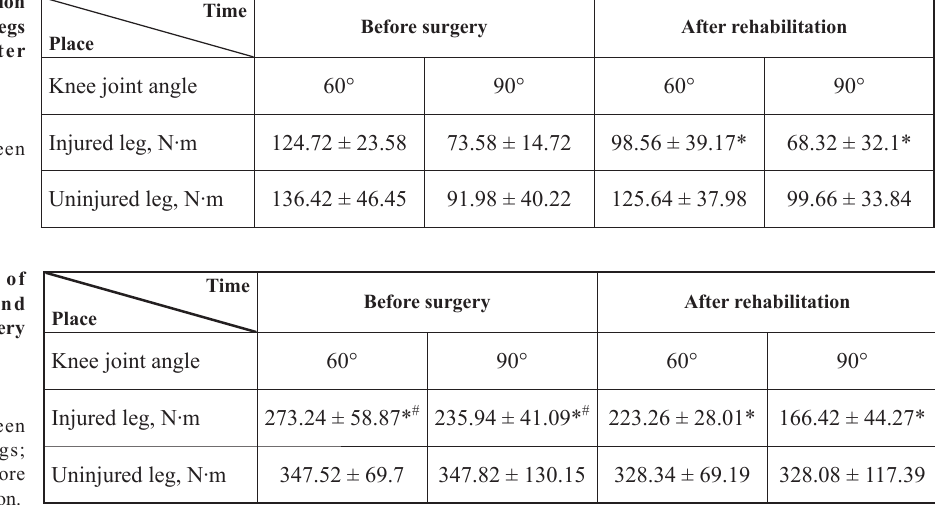
Table 1. MVC torque of fl exion of injured and uninjured legs before surgery and after rehabilitation